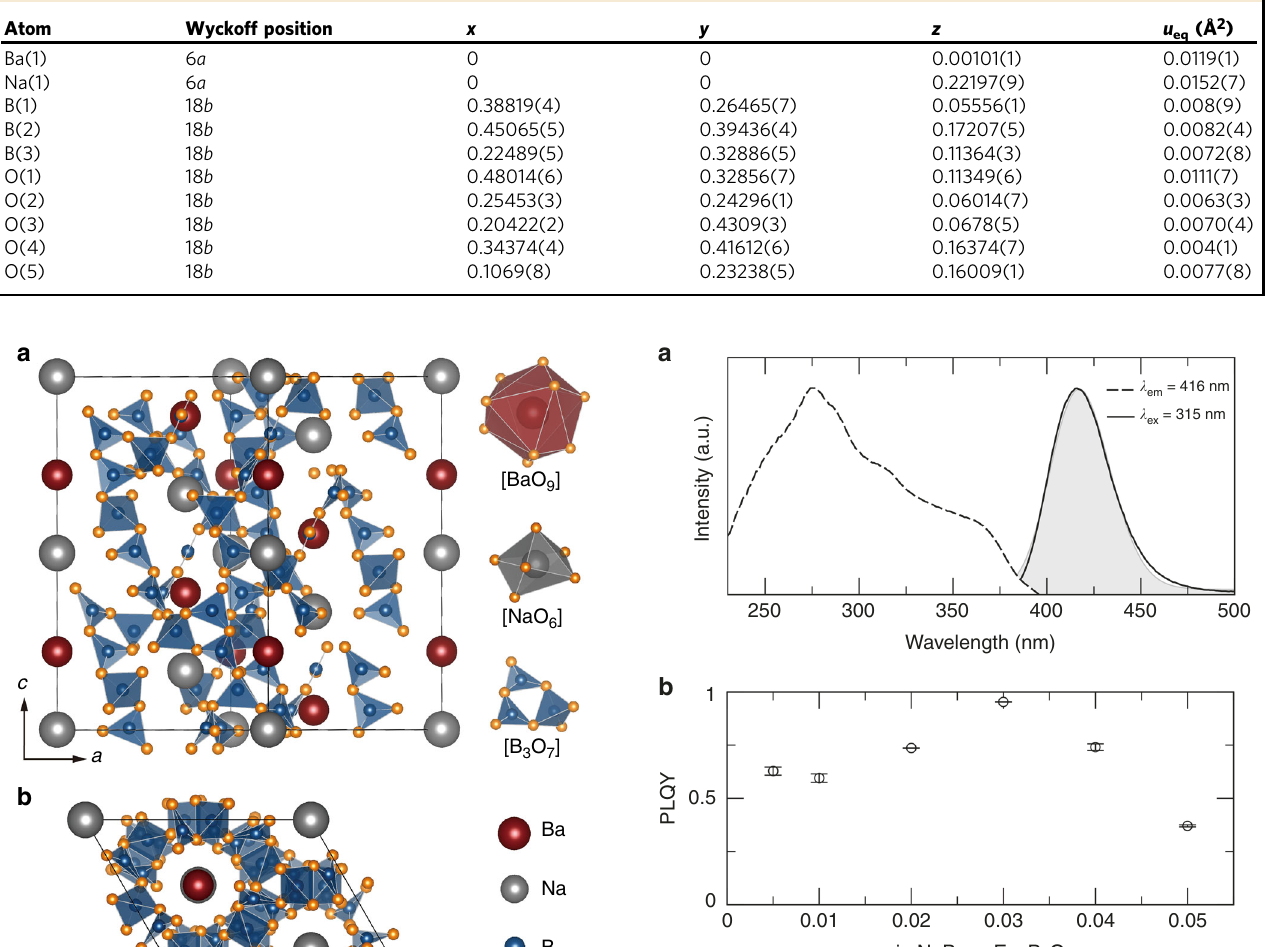
Table 2 Unit-cell parameters determined using Rietveld re fi nement